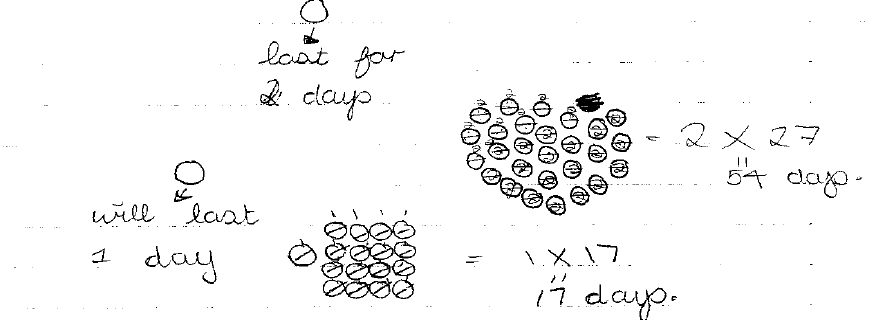
Figure 4: Part B – Liya’s second attempt at solving the cat pills